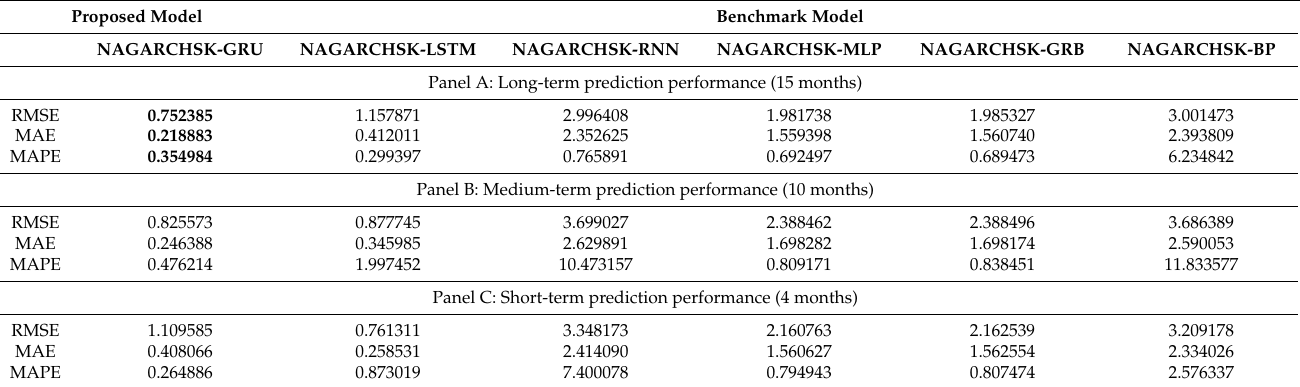
Table 4. Prediction performance of the pricing model considering the feature of time-varying, high- order moment.